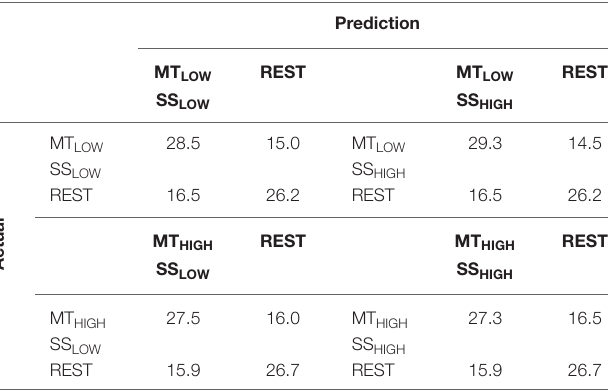
TABLE 5 | Confusion matrices summarizing the classification performance of the cross-classifiers (CC) using alpha band features, trained on MT and tested with SS averaged over all subjects ( n =